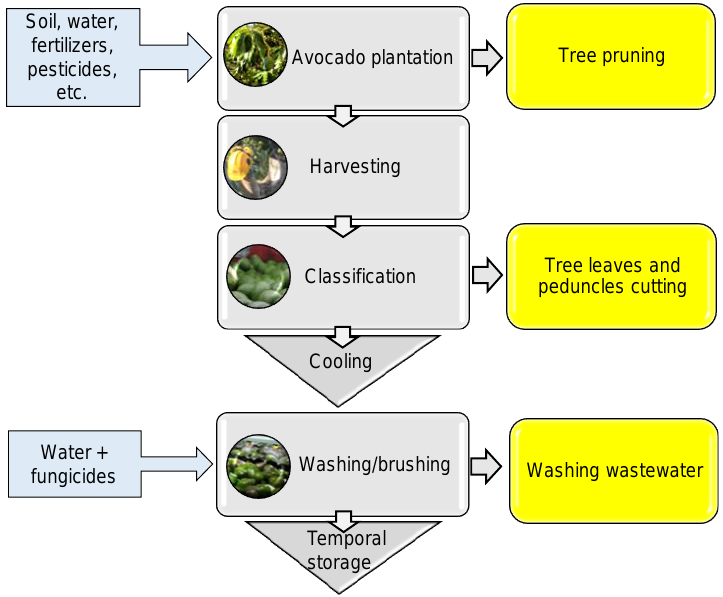
Figure 3. Activities prior to commercialization of avocado and by-products / waste generated in the field (yellow squares).